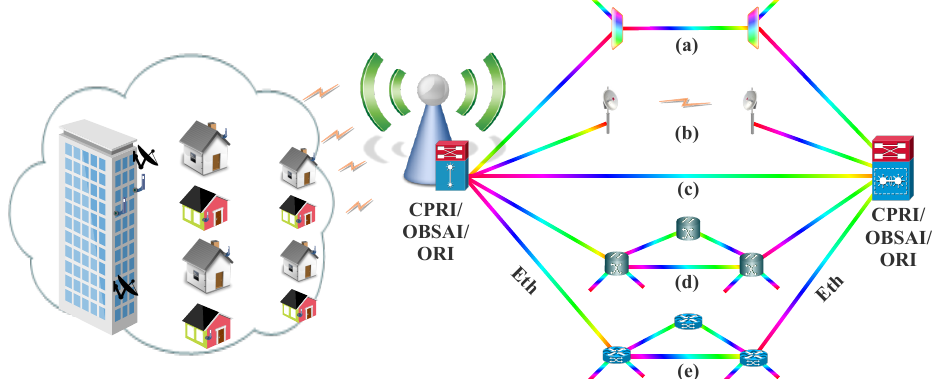
Figure 21. Potential 5G transport solutions: ( a ) WDM-PON, ( b ) microwave, ( c ) point-to-point, ( d ) OTN, and ( e )